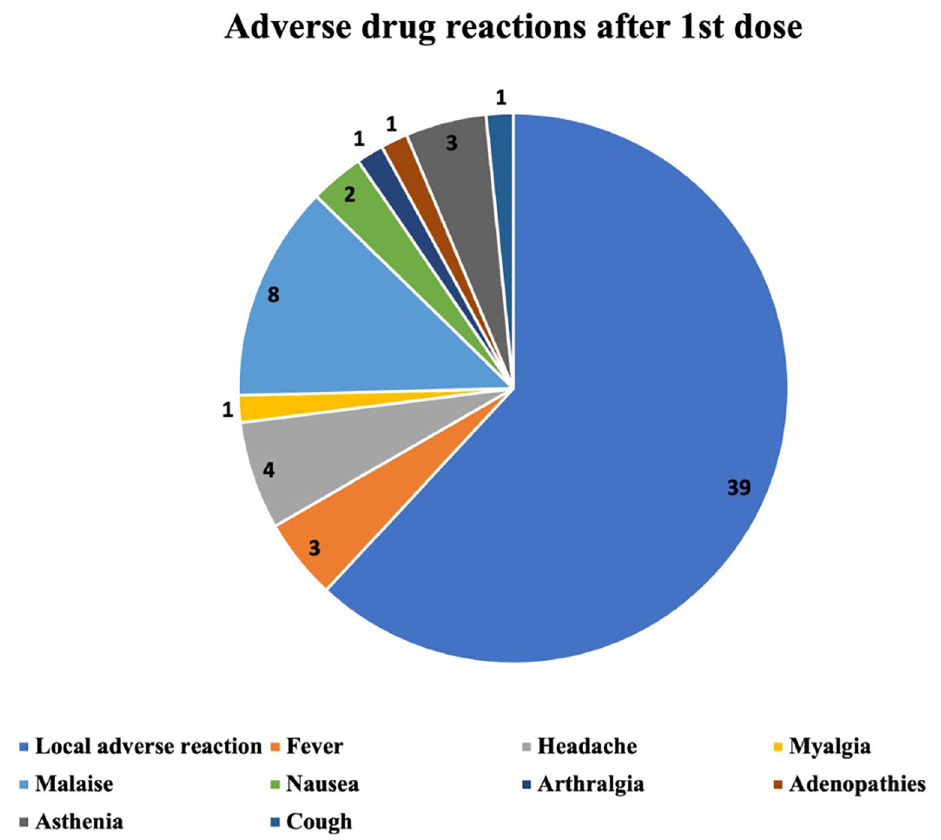
Figure 2. Number and type of adverse drug reactions after 1st